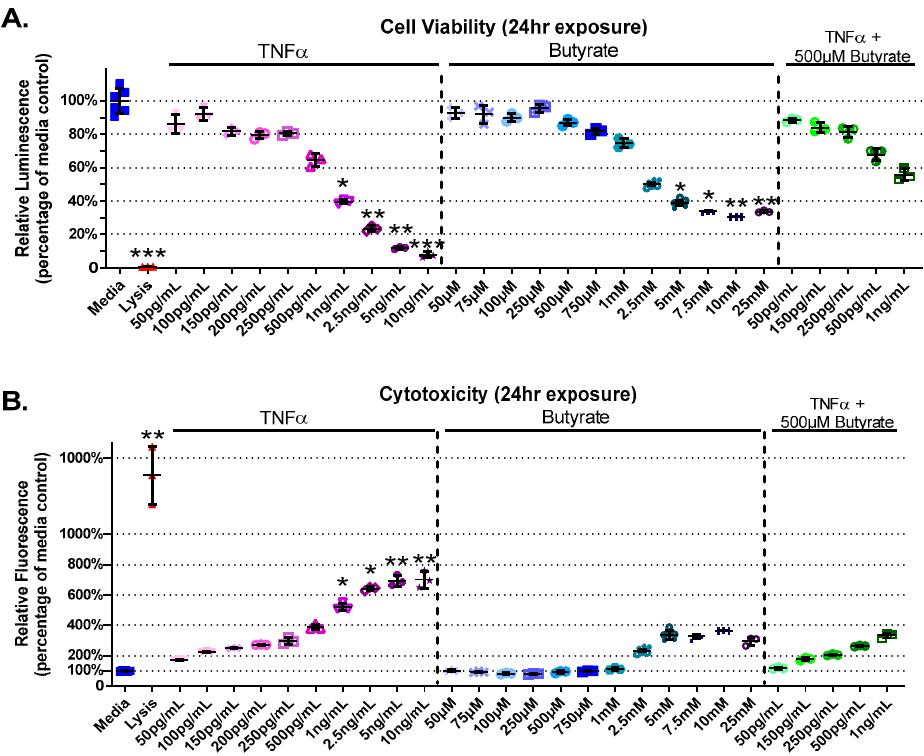
Figure 1. Viability and cytotoxicity after 24 h exposure to butyrate and TNF α . Lysis solution provided with the CellTox Green kit was used as positive control. ( A ) Viability: relative luminescence is graphed for each experimental group and is normalized to the medium control (horizonal bar represents mean relative fluorescence ± standard deviation). ( B ) Cytotoxicity: relative fluorescence is graphed for each experimental group and is normalized to the lysis control (horizonal bar represents mean relative fluorescence ± standard deviation). Asterisks indicate degree of significance from medium control (Kruskal–Wallis test followed by a Dunn’s multiple comparison test relative to the medium control, n = 3/experiment, * = p < 0.05, ** = p < 0.01, *** = p < 0.001). Note: for statistical comparisons made amongst all groups, see Supplemental Data Table